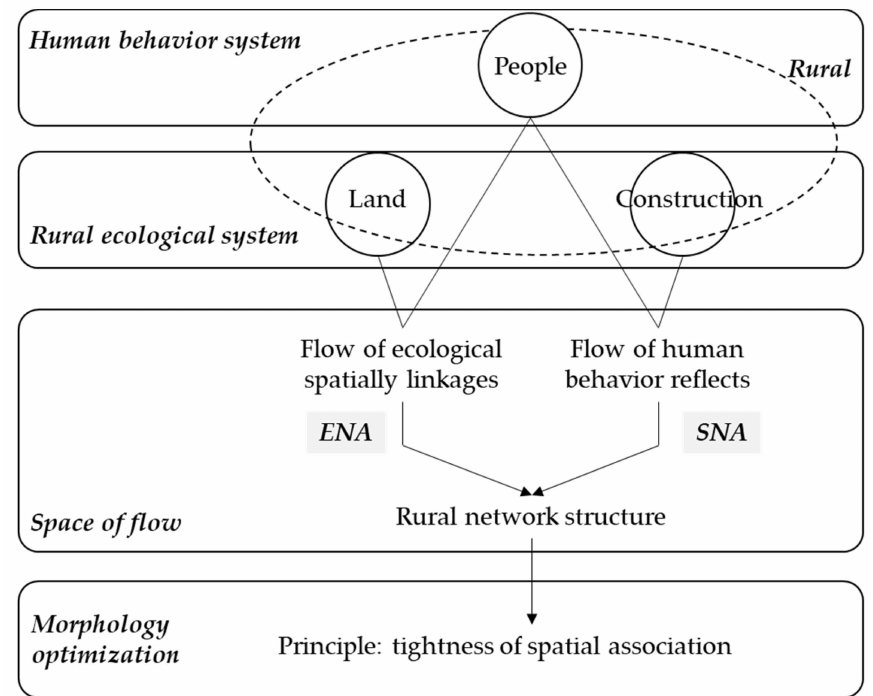
Figure 2. Logical framework for the evaluation of rural spatial morphology optimization based on space of